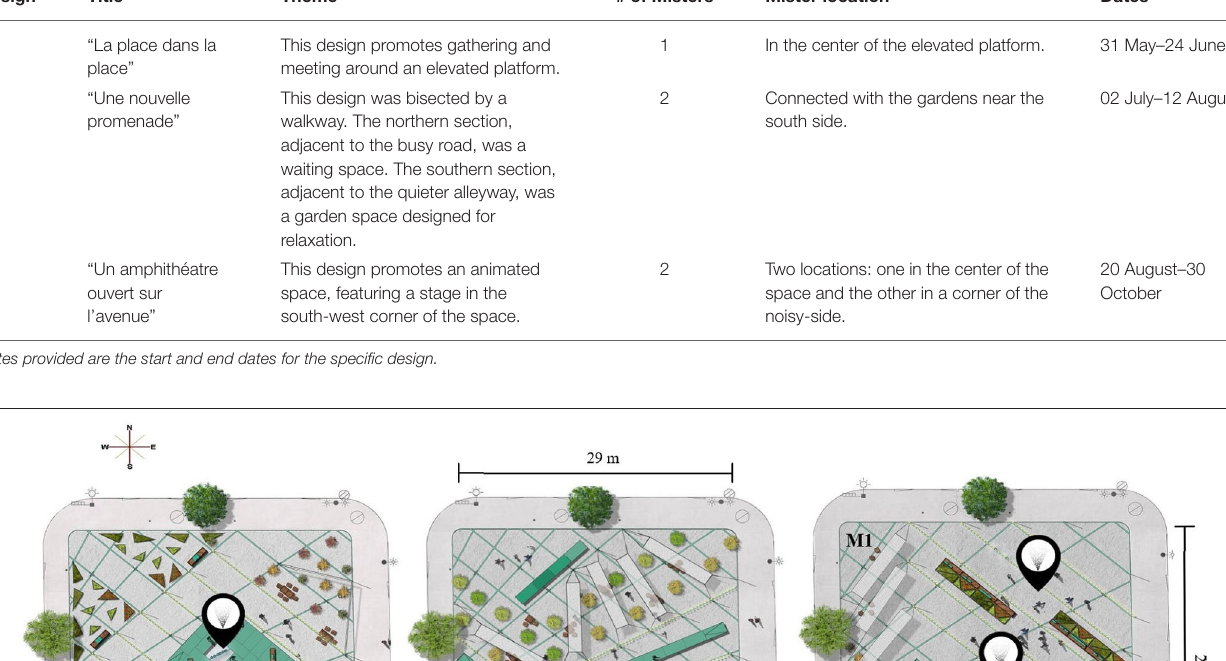
TABLE 1 | Description of the designs and the locations of each mister within the space.